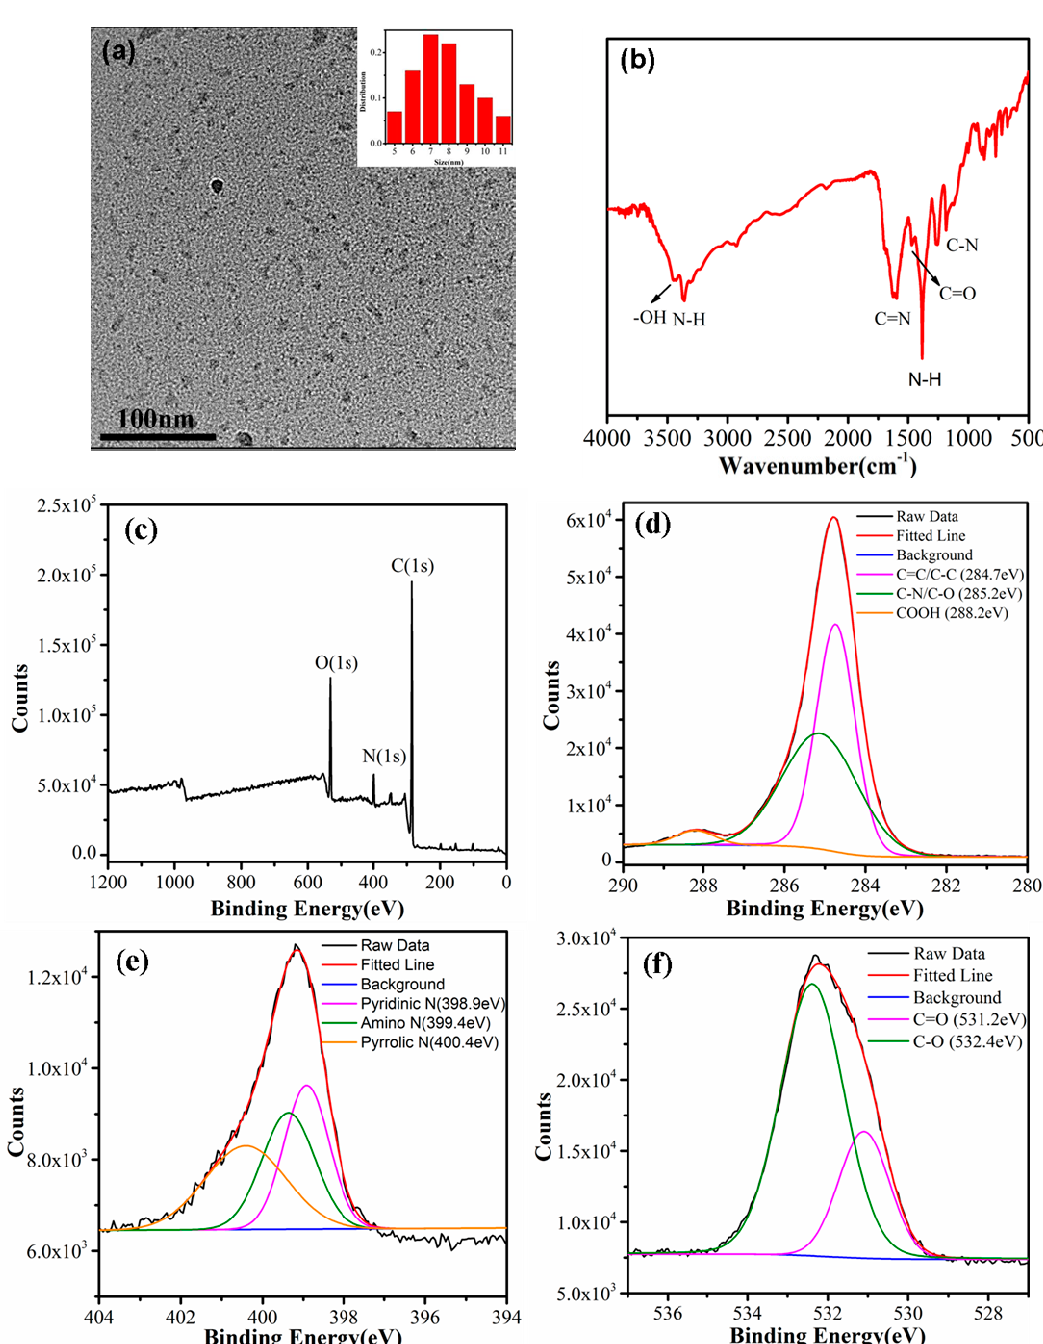
Figure 1. ( a ) TEM image of the CDs. The inset in ( a ) is the particle size distribution histogram. ( b ) FTIR image of the CDs. ( c ) XPS survey spectrum of the CDs. ( d – f ) High-resolution XPS spectra of C1s, N1s, and O1s, respectively.